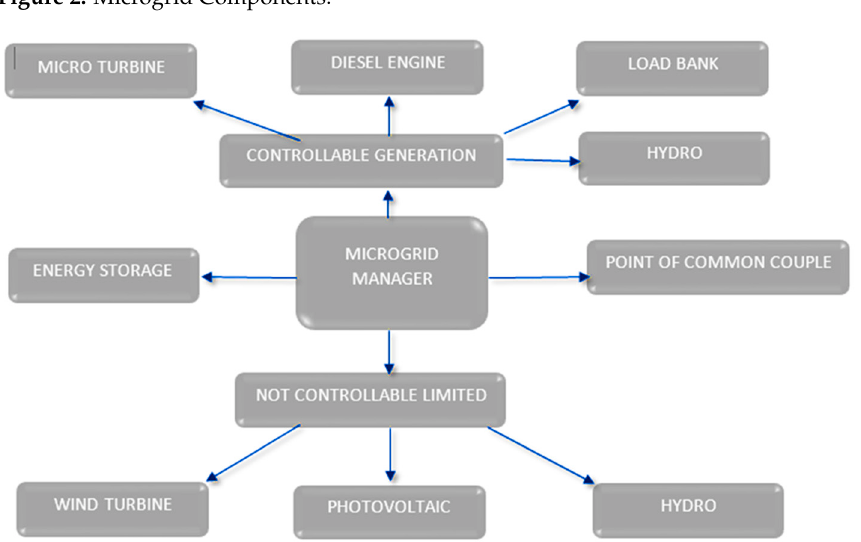
Figure 3. Depicts a basic microgrid system.